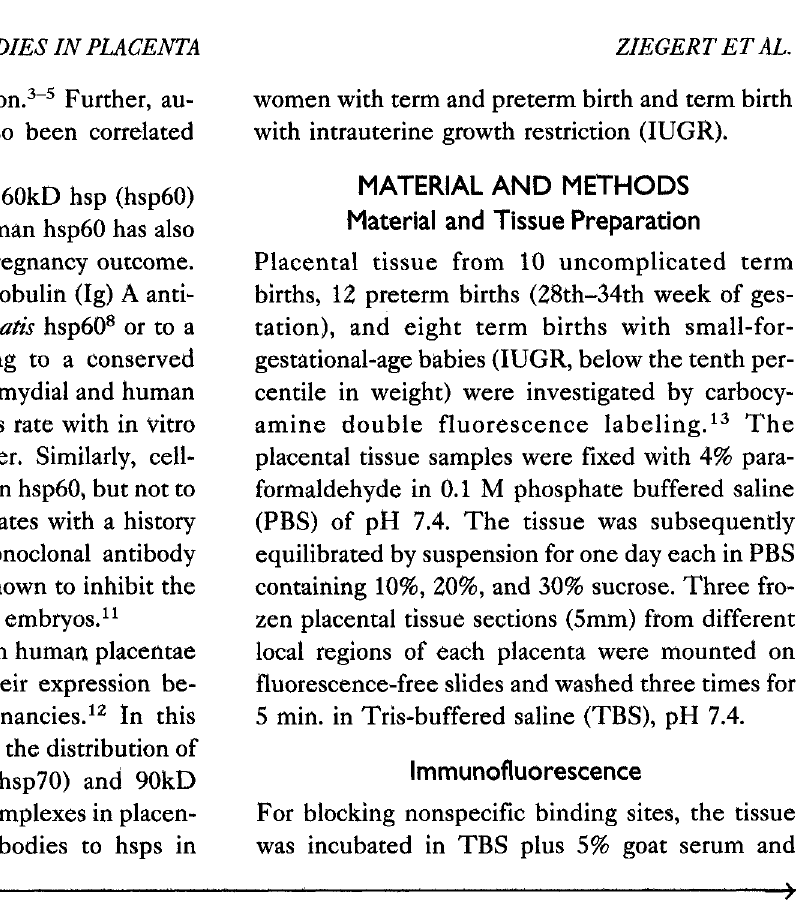
Fig. I. Double labeling of hsp60 and hsp70 and the antibodies (IgG) in cryosections of placental tissues from a preterm labor case by combination of red (Cy3) and green (Cy2) immunofluorescence. Notice the yellow appearance of cells with both hsp60 and hsp70 and anti-hsp60 or anti-hsp70 antibodies. Pairs of photomicrographs (A and B as well as C and D) present the same structures mono-labeled for hsp (A, D), for antibodies (R, E) and double stained for the antibody attached to hsp60 or hsp70 (C, F). (/x.) Immunodetection of hsp60 from a case of preterm labor by green fluorescent Cy2-goat anti-rabbit IgG. Green fluorescent Cy2 immunostaining of human hsp60 in cells of the surface layer (syncytiotrophoblast) and stromal cells is shown (magnification x150). (1) Immunodetection of antibodies against hsp60 from a case of preterm labor by red fluorescent Cy3-goat anti-human IgG. Red fluorescent Cy3 immunostaining of human hsp60-antibodies in ceils of the surface layer (syncytiotrophoblast) and stromal cells is shown. (magnification x 150). (C) Visualization of the hsp60.antibody complexes in the same frame of cryosection as in A and B. Placental tissue was double labeled by using polyclonal rabbit anti-human hsp60 and, subsequently, red fluorescent Cy3-goat anti-human IgG and green fluorescent Cy2-tagged goat anti-rabbit IgG. The double exposure of both immunoreactivities leads to the yellow appearance of the hsp60-antibody complex (arrows). Green fluo- rescence shows hsp60 not attached by anti-hsp60 antibodies. Red fluorescence demonstrates other placental human IgG not specific for hsp60 (magnification x 150). (D) Staining of hspT0 from a case of preterm labor was revealed by red fluorescent Cy3-goat anti-rat IgG in cells of the surface layer and in stromal cells (magnification x75), (E) Staining of hsp70 antibodies from a case of preterm labor was revealed by green fluorescent Cy2-goat anti-human IgG. Green fluorescent Cy2 immunostaining of human hsp70-antibodies in cells of the surface layer and in stromal ceils is shown (magnification x75). (t:) Allocation of hspT0 (as shown in D) and hspT0-antibody complexes from a case of preterm labor. Placental tissue was simultaneously visualized by using monoclonal rat anti-human hsp70 and, subsequently, green fluorescent Cy2-goat anti-human IgG and red fluorescent Cy3-tagged goat anti-rat IgG (switch of the fluorochromes in comparison with C). The double exposure of both immunoreactivities leads to the yellow appearance ofthe hspT0-antibody complexes (magnification x75). (G) Staining of hspg0 from a preterm labor patient by applying red fluorescent Cy3-goat anti-rabbit IgG in cells of the surface layer and in stromal cells. No hspg0-antibody complexes were seen in the placental tissue (magnification x500). (FI) Demonstration of hsp60- antibody complexes in the surface layer facing the cavum intervillosum and in stromal cells (yellow color, arrow). Note the predominant localization in cells of the surface layer (syncytiotrophoblast). Green fluorescenceindicates the localization of hsp60. Red fluorescence shows other human placental IgG not specific for hsp60 and therefore not bound to hsp60 (mag- nification x500). (I) Visualization of hsp70-antibody complexes in the surface layer facing, the cavum intervillosum and in stromal cells. Red fluorescence reveals the localization of hspT0 not associated with anti-hspT0 antibodies. Notice the predominant localization in cells of the surface layer (magnification